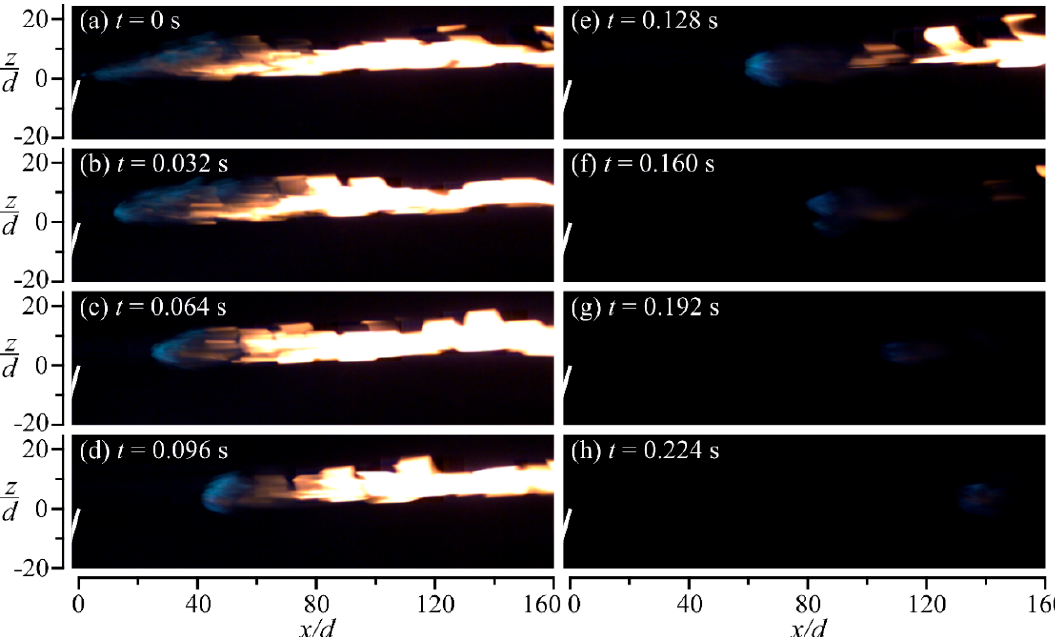
Figure 5. Flame blow-off process. Exposure time = 8 ms. θ = 15°, and R = 6.40.